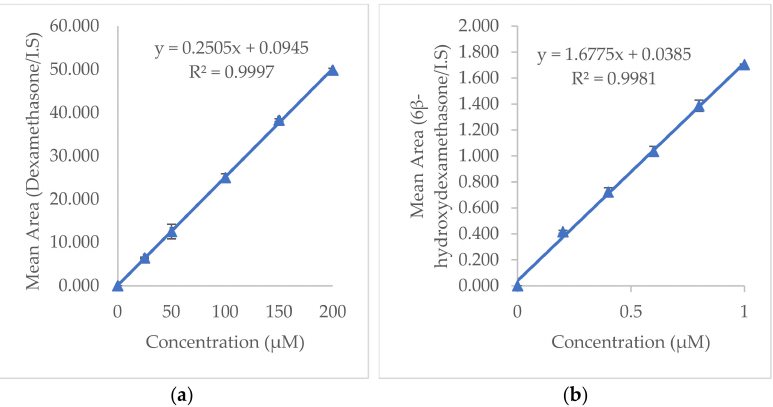
Figure 3. Calibration curves displaying linearity over the selected range: ( a ) dexamethasone; ( b ) 6 β − hydroxydexamethasone.